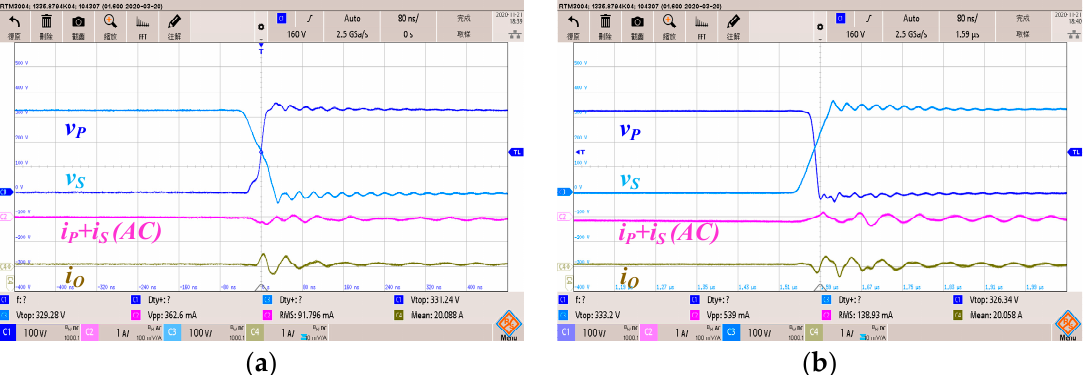
Figure 30. Measured waveforms of the switching node voltage, sum of inductor current ripple and output current using the low output ripple dead time modulation e: ( a ) dead time interval: t 1 ~t 2 ; ( b ) dead time interval: t 3 ~t 0 +T . [scale v P (Ch1): 200 V/div; i P + i S ( AC ) (Ch2): 5 A/div; v S (Ch3): 200V/div; i O (Ch4): 1A/div; time: 80 ns/div].